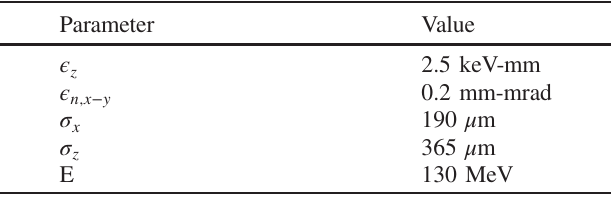
TABLE III. Main beam parameters at the injector exit.